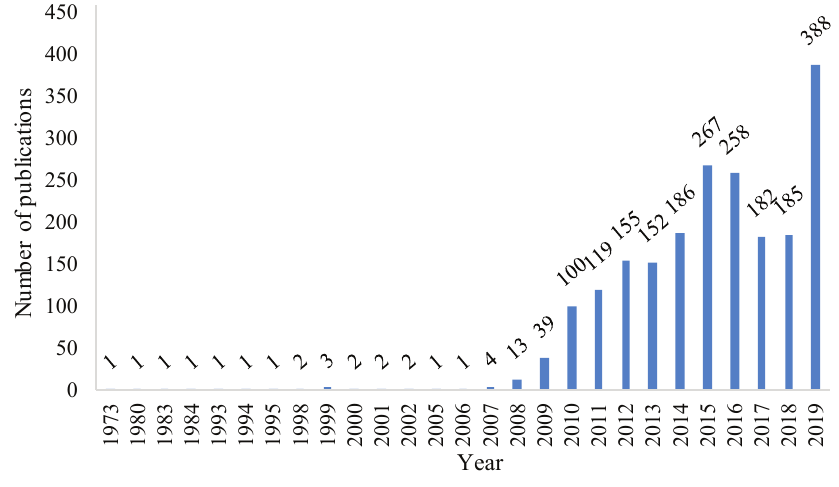
Figure 3. Growth of research from 1973 to 2019.